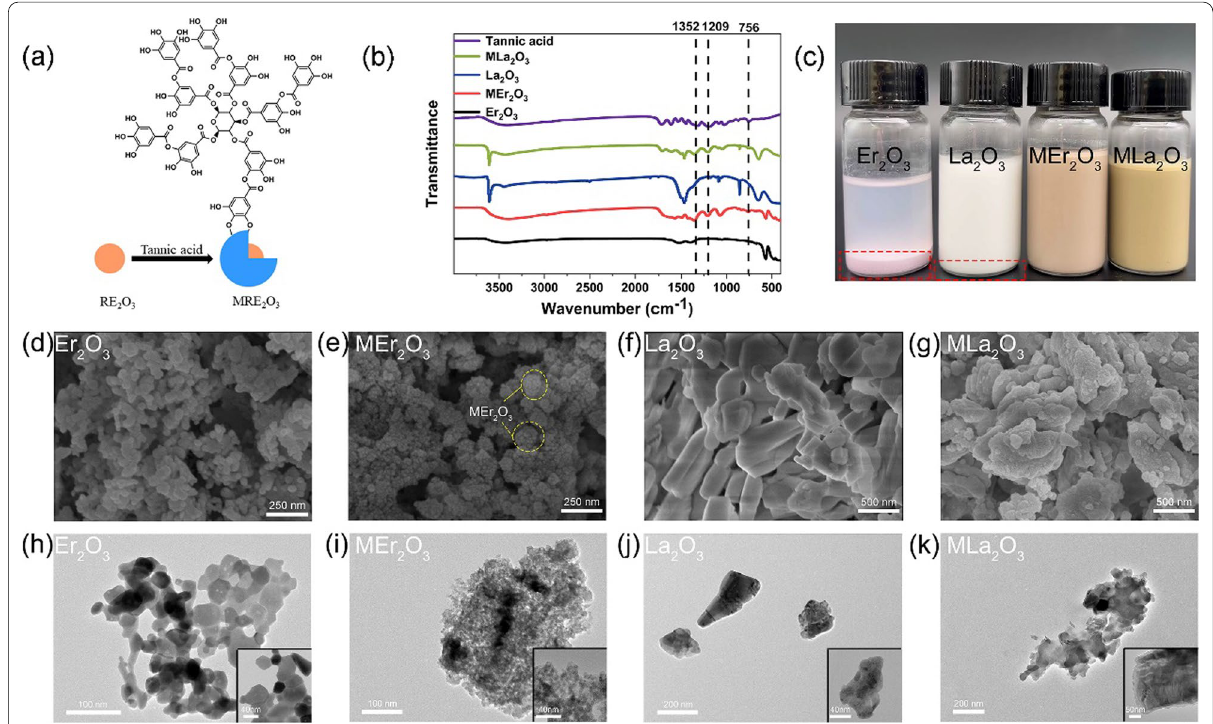
Fig. 1 a Preparation of MRE 2 O 3 ; b FT-IR spectra of Er 2 O 3 , MEr 2 O 3 , La 2 O 3 , and MLa 2 O 3 ; c Ethyl alcohol dispersibility of Er 2 O 3 , MEr 2 O 3 , La 2 O 3 , and MLa 2 O 3 with the same concentration; SEM images of d Er 2 O 3 ; e MEr 2 O 3 ; f La 2 O 3 ; and g MLa 2 O 3 . TEM images of h Er 2 O 3 ; i MEr 2 O 3 ; j La 2 O 3 ; and k MLa 2 O